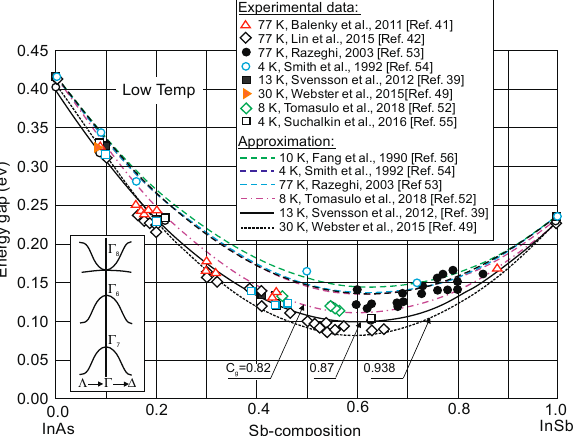
Figure 5. InAs 1 − x Sb x bandgap energy versus the Sb composition at low temperatures. The experimental Figure 5. InAs 1–x Sb x bandgap energy versus the Sb composition at low temperatures. The data are taken with di ff erent papers as indicated in the key experimental data are taken with different papers as indicated in the key [39,41,42,49 ,52-56].